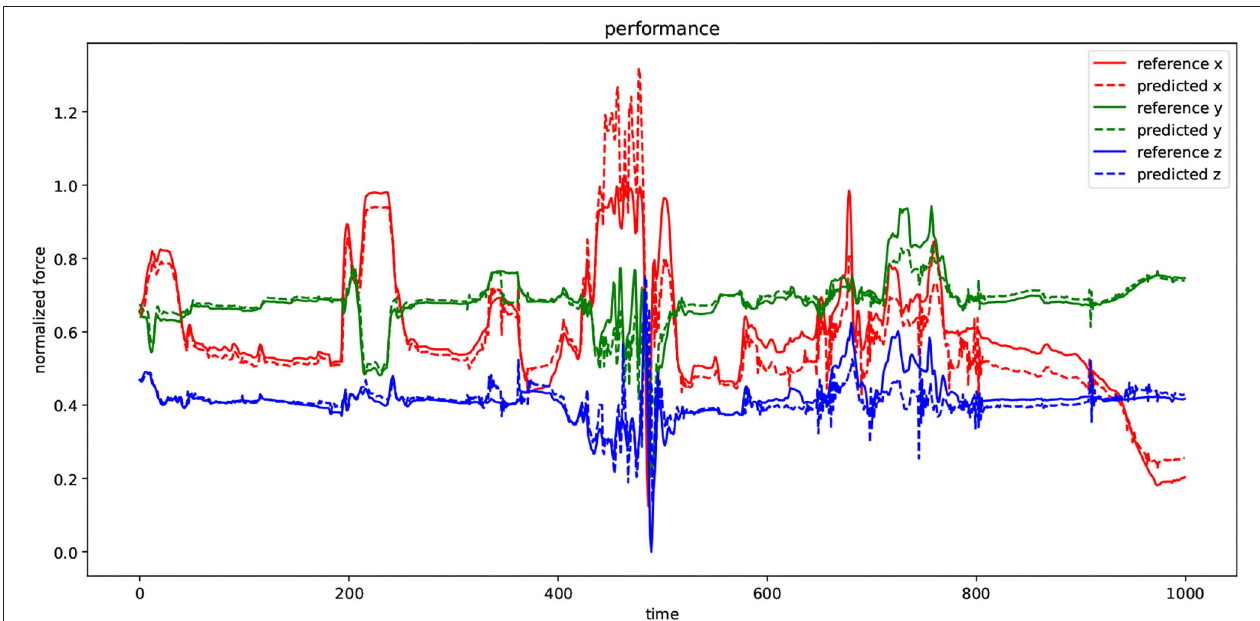
FIGURE 9 | The diagram depicts the performance of the DHG in a specified window with 1,000 data samples. Every dimension of force-feedback signals (x, y, and z) has a reference and a predicted demonstration. The value of the references has been normalized and also the model has been trained by normalized training set as well. The DHG makes predictions on force feedback in every time t using 20 previous data